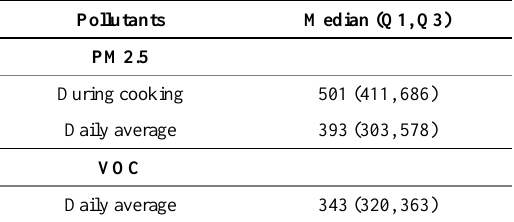
Table 3. Showing overall mean PM2.5 and VOCs in the whole